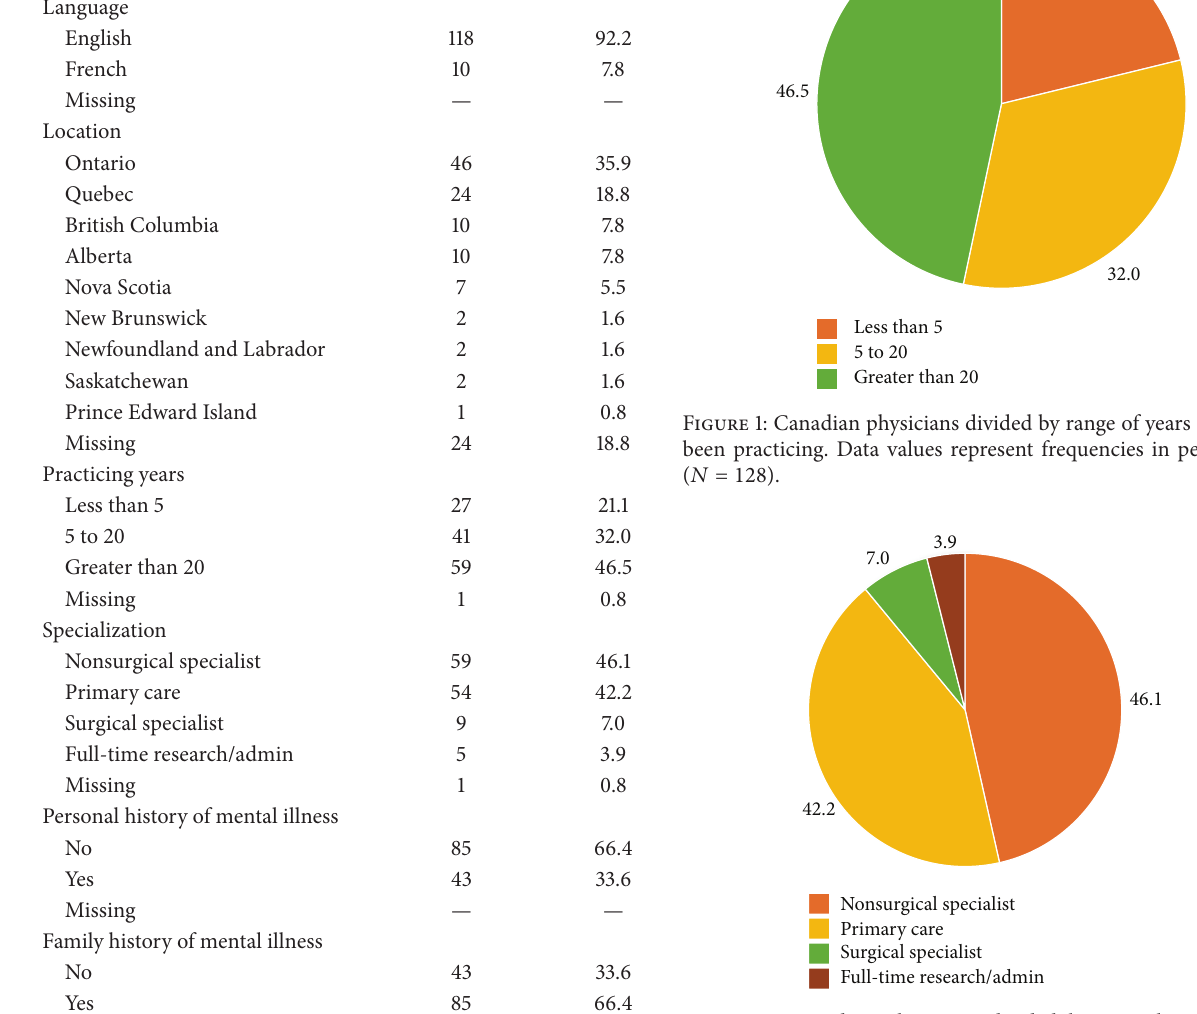
Figure 2: Canadian physicians divided by specialization. Data values represent frequencies in percentages ( 𝑁 = 127